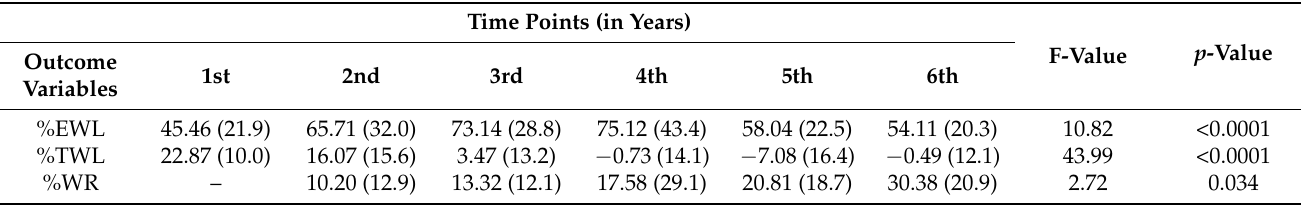
Table 2. Comparison of repeated measure (%EWL, %TWL, and %WR) mean (SD) values of study subjects across the six time points and the difference between each time point and at the end observation time point.